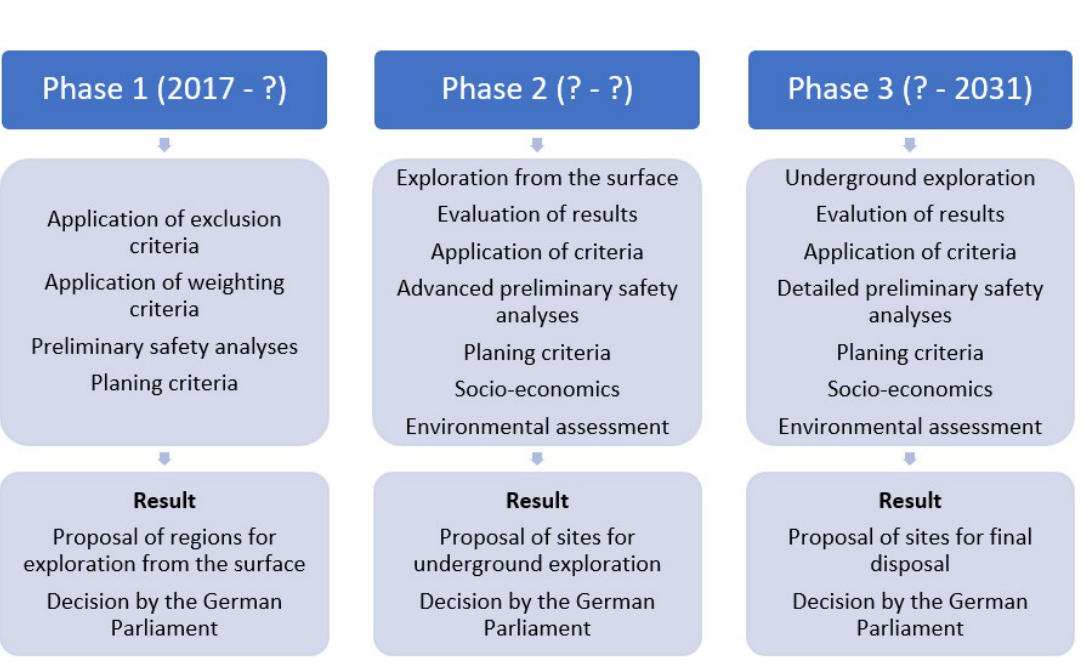
Figure 2. Phases within the site selection process.